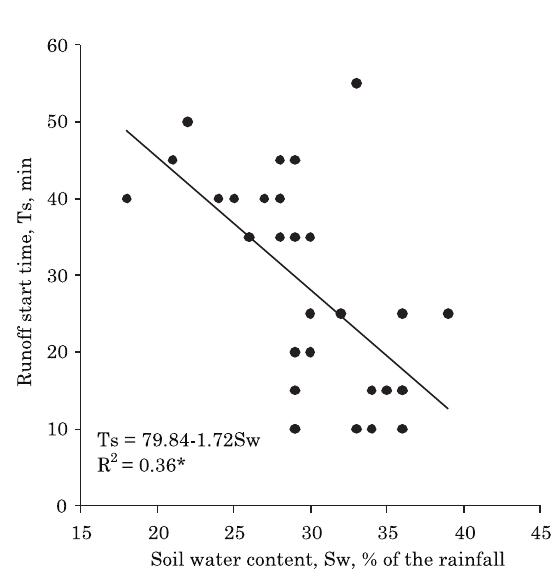
Figure 2. Relationship between runoff starting time (Ts) and soil water content before rainfall, Sw, in the 0-10 cm layer, considering all treatments and rainfall tests